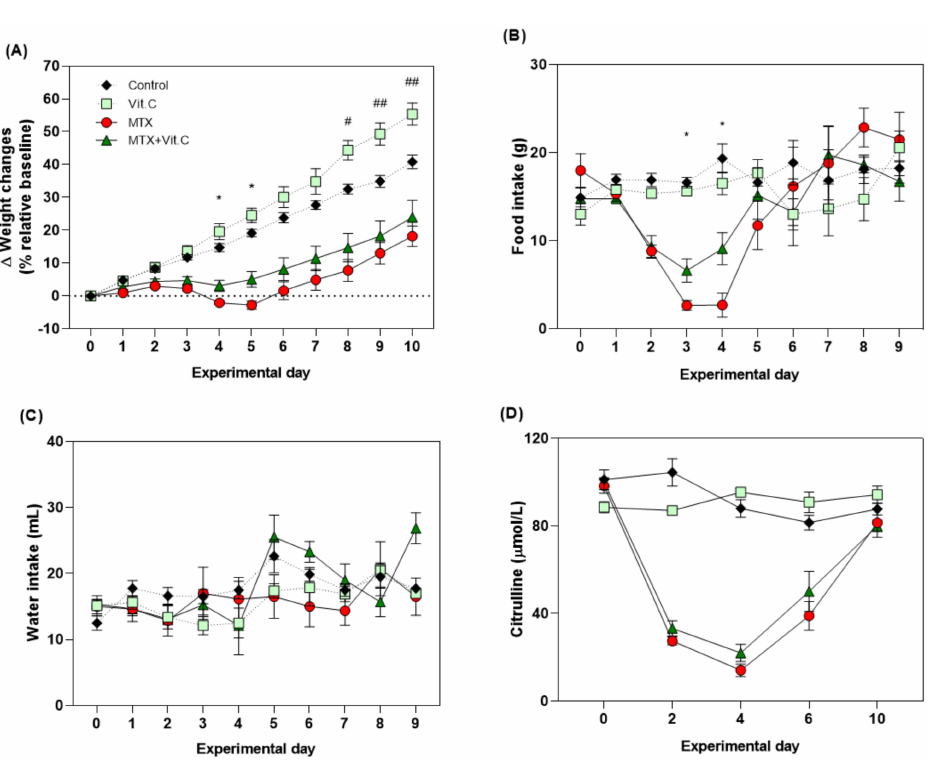
Figure 3. Effects of vitamin C (50 mg/day/rat) on the clinical parameters. ( A ) Bodyweight relative to weight at day 0, which was set at 100%. ( B ) Food intake in grams per day. ( C ) Water intake in ml per day. ( D ) Plasma citrulline level ( µ mol/L) measured at days 0, 2, 4, 6 and 10 after MTX injection. All data are presented as mean ± SEM. # ( p < 0.05) and ## ( p < 0.01) represent the differences between the control group and vitamin C-supplemented rats. * ( p < 0.05) represent the significant changes between MTX-treated rats supplemented with vitamin C and MTX-treated rats